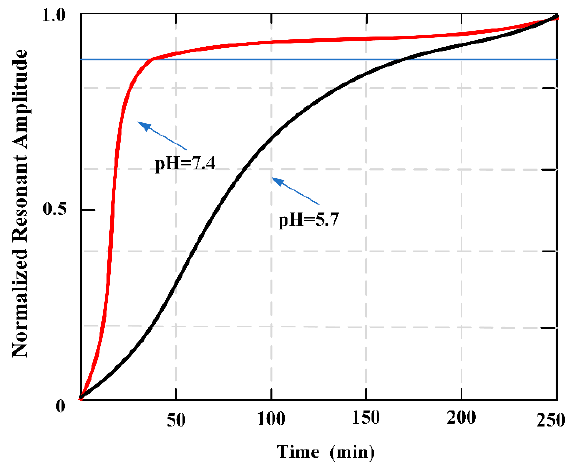
Figure 13. Change in the normalized resonant amplitudes of magnetoelastic sensor (MES) when coated hydrogel degraded them at pH 5.7 and 7.4. The curves represent the average value of three